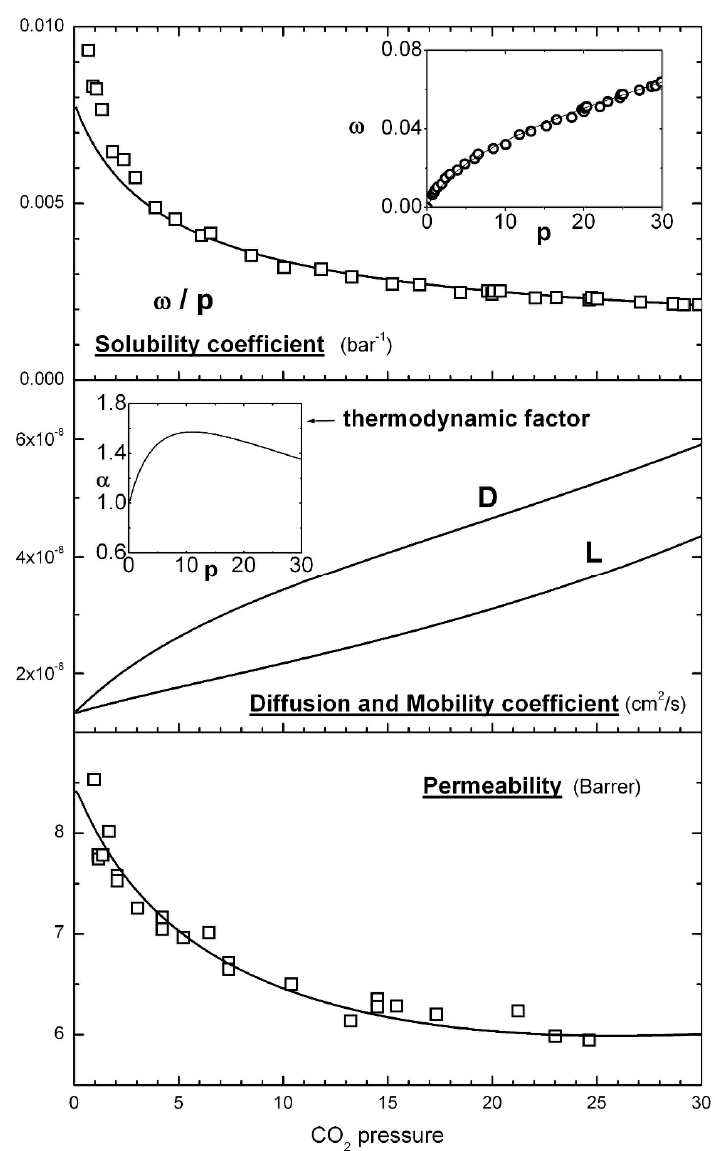
Figure 1. Illustration of the NELF/STM-GP model for the solubility and permeability of gases in a glassy polymer; in the example, the experimental data reported by Koros et al. [50] of CO 2 in glassy polycarbonate (PC) at 35 °C are reported together with the model curves [23].